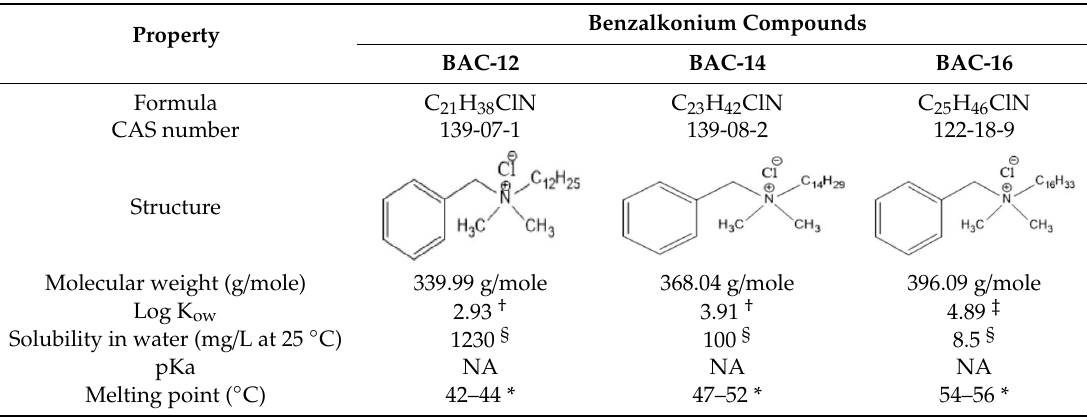
Table 5. Physicochemical properties of benzalkonium chlorides.